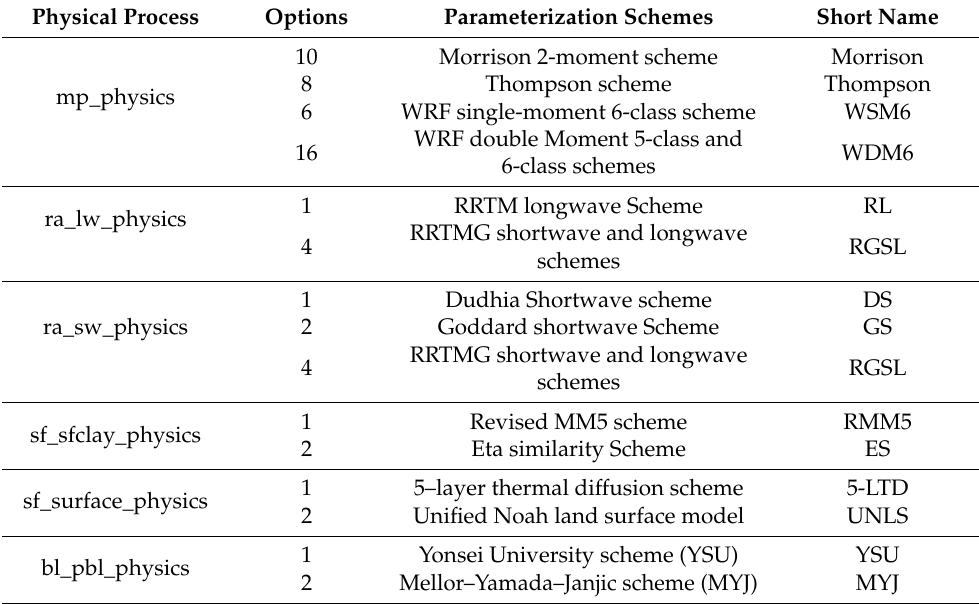
Table 2. Introduction of physical parameterization